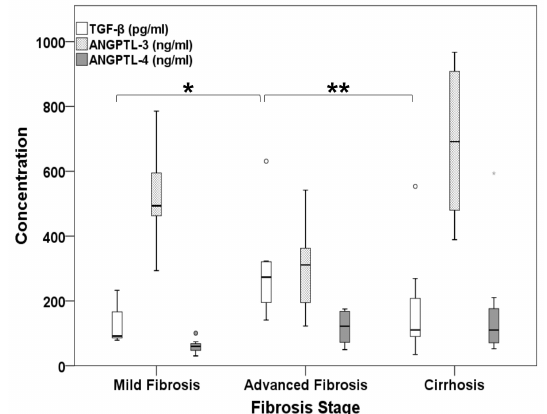
Figure 6. Serum levels of the key profibrotic cytokine TGF- β in correlation with ANGPTL-3 and ANGPTL-4 in HCV patients with mild fibrosis, advanced fibrosis and cirrhosis. The naturally active form of TGF- β (white box plots) was determined by sandwich ELISA from the sera of HCV patients prior to DAA treatment and is plotted together with ANGPTL-3 (light grey box plots) and ANGPTL-4 (dark grey box plots) levels against fibrosis stage. Statistically significant differences within groups are denoted by one star ( p -value ≤ 0.05), or two stars ( p -value ≤